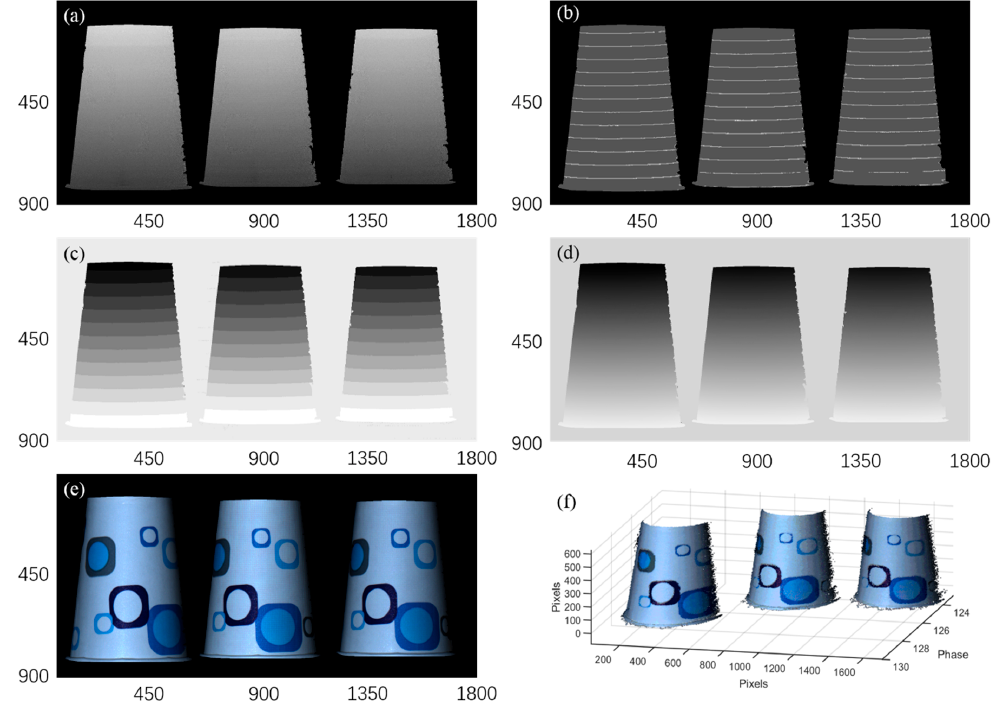
Figure 13. 3D reconstruction of the isolated objects using the proposed neural network. ( a ) Phase distribution of one single period; ( b ) the output label image from network I; ( c ) the integer calculated using the output label image with the help of ( a ); ( d ) the unwrapped phase distribution; ( e ) the 2D color image for comparison; and ( f ) 3D reconstruction using ( c ) and ( d ).